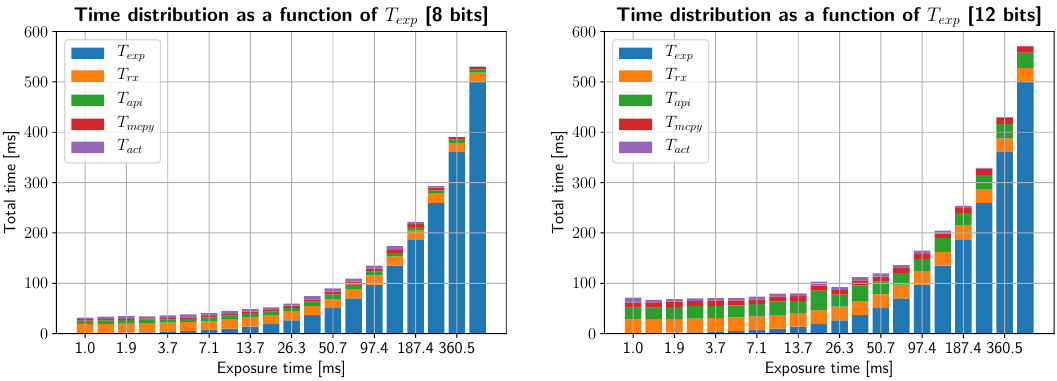
Figure 5. Line measurement time distribution for different exposure times, and bit depth (left and right subplots correspond to 8- and 12-bit depth, respectively). The total time spent in each line is a combination of exposure time T exp (in blue), network transmission time T rx , dynamic library time T api (in green), memory buffer copying T mcpy (in red) and actuator delays T act (in